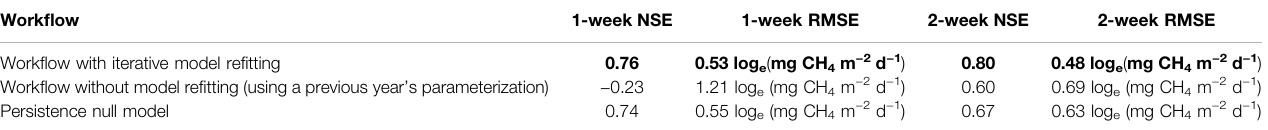
TABLE 2 | Forecast evaluation determined by Nash-Sutcliffe Ef fi ciency (NSE) and root mean square error (RMSE) at 1- and 2-week forecast horizons.The best-performing work fl ow evaluation statistics (as indicated by the highest NSE and lowest RMSE for each forecast horizon) are highlighted in bold for each horizon.